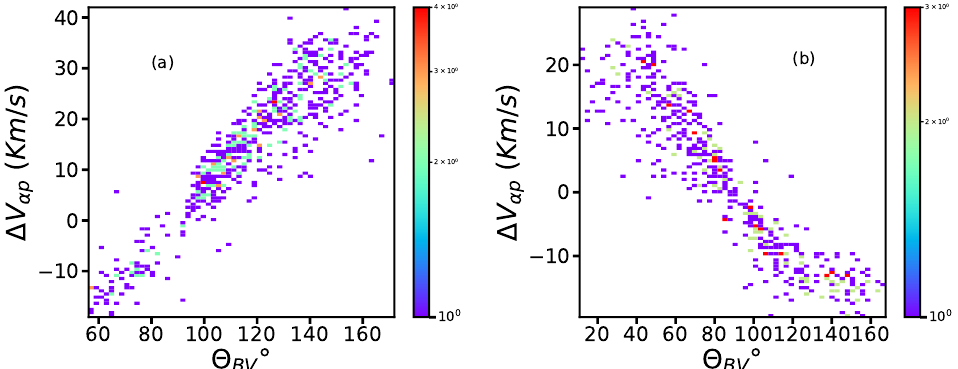
Figure 4. 2D histogram plot of alpha proton drift speed as a function of θ BV of the fast wind intervals observed by WIND at 1 au on 10 June 2015 ( a ) and 15 March 2007 ( b ). The color bar represents the number of counts.